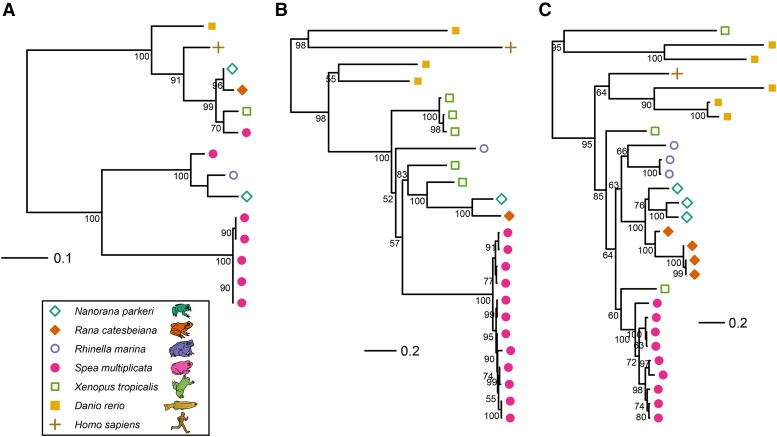
Gene trees for genes with elevated copy numbers in Sp. multiplicata. We utilized Usearch (Edgar 2010) to identify gene enrichments in Spea compared to four other anurans. We then retrieved copies of the gene in question for humans and zebrafish from Uniprot. Trees were built from alignments including only sites where all species had data. Distance is in number of substitutions per site. Node labels are shown for all nodes with at least 50% bootstrapping support over 100 iterations. A hyaluronan synthase 3 (hyas3; seven copies of Sp. multiplicata); B nodal (12 copies); and C zona pellucida glycoprotein 3 (zp3; nine copies).